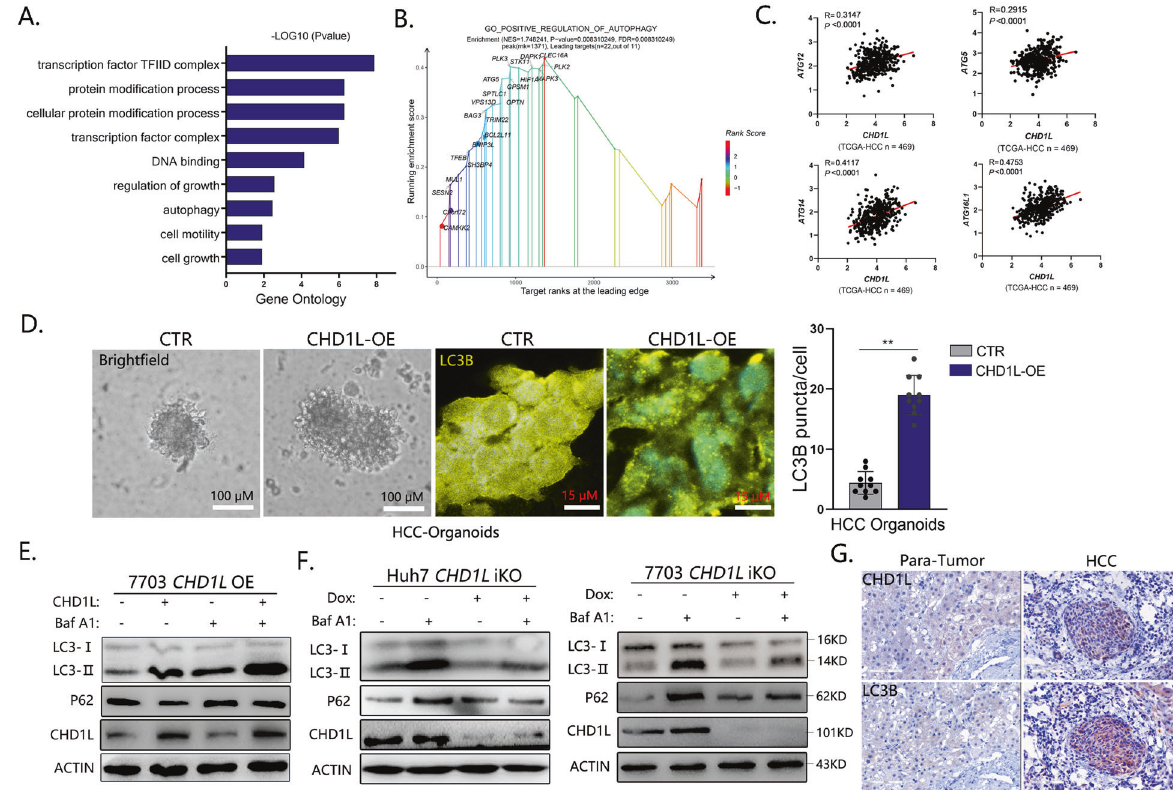
Fig. 2 CHD1L promotes autophagy in HCC. A Enrichment of the gene ontology (GO) terms of differential mRNAs in CHD1L- vs vector-QGY- 7703 clones. B Performance of GSEA based on the differential genes in CHD1L- vs vector-QGY-7703 clones. Enrichment analysis was performed on the indicated gene sets. C Correlation plots show expression of indicated genes and CHD1L in 469 primary HCC tumor and para-tumor samples analyzed using RNA-sequencing in TCGA. D Bright light and immuno fl uorescence for endogenous LC3B images of patient-derived organoid (PDOs) established from HCC. Cystic PDO structures were recognized starting on day 6. Bar was as indicated, quanti fi cation of LC3B puncta per cell for Vector or forced CHD1L group. (** p < 0.01; Student ’ s t test; Mean ± SD, n = 10/group). E WB analysis for changes in LC3 conversion and P62 level affected by overexpression of CHD1L in the presence or absence of 80 nM Baf A1 (6 h). The QGY- 7703 cells were transiently transfected with GFP-tagged CHD1L expressing constructs or the control vector. LC3-I, non-lipidated LC3; LC3-II, lipidated LC3. The β -actin protein was as a loading control. F WB analysis for changes in LC3 conversion and P62 level affected by CHD1L- de fi cient in the presence or absence of 80 nM bafA1 (6 h) in Huh7 and QGY-7703-iKO cells. G Representative IHC images for the expression of CHD1L and LC3B in primary HCC